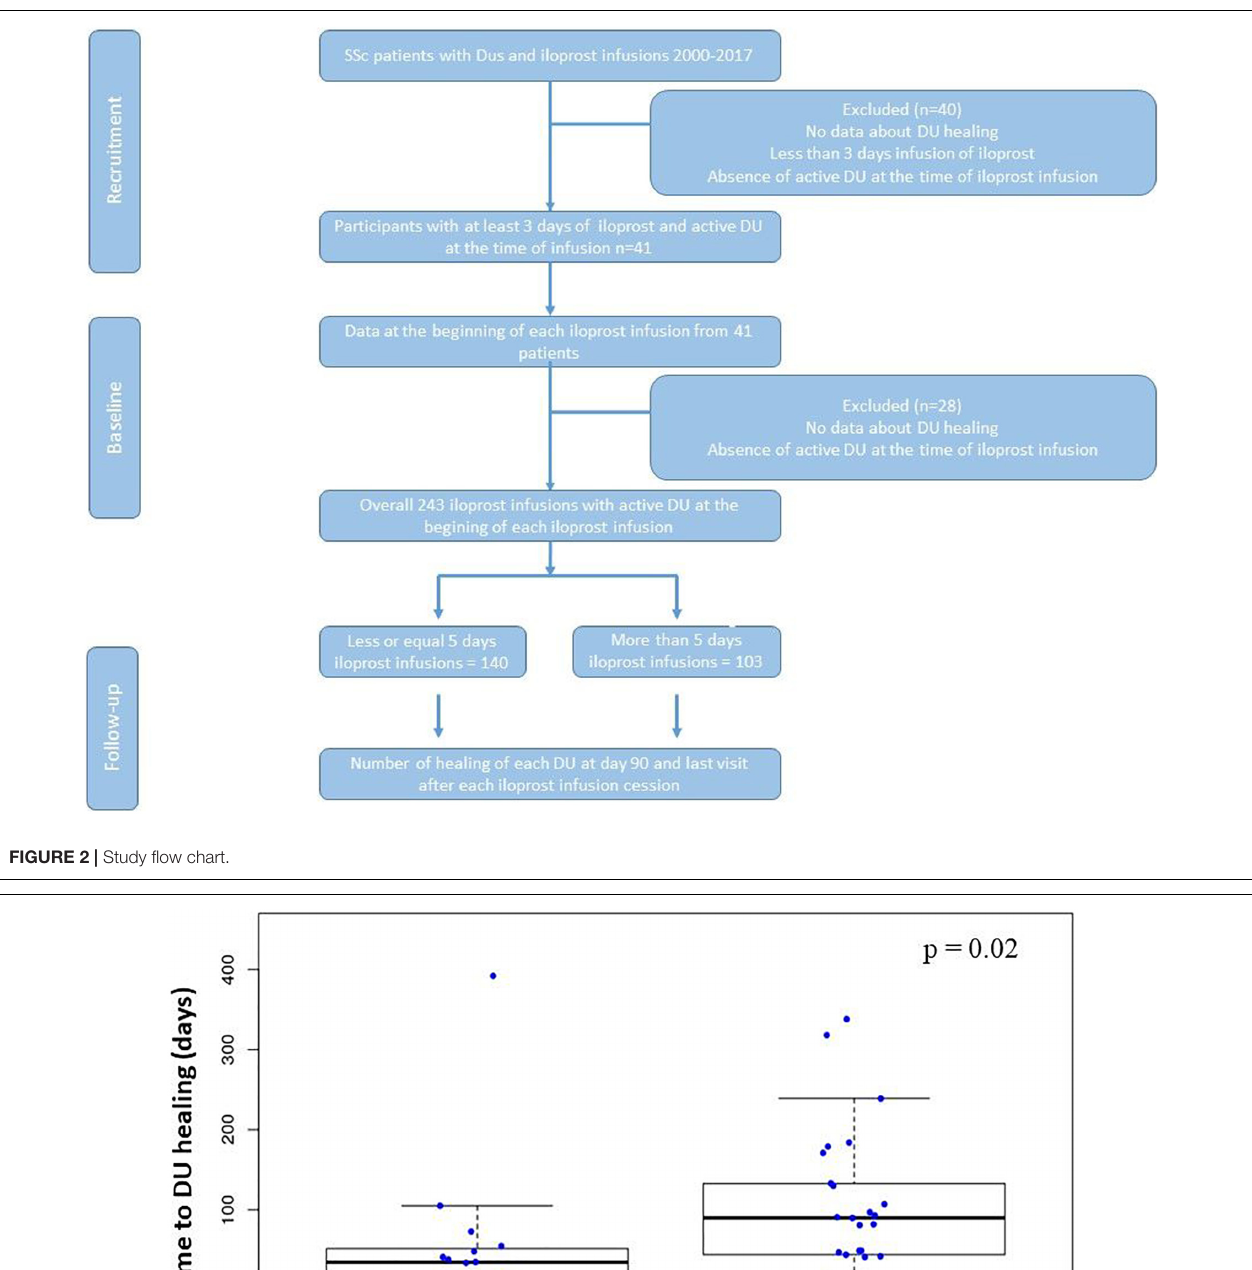
FIGURE 3 | Time to digital ulcers healing in SSc patients with iloprost infusion less or more than 5 days.